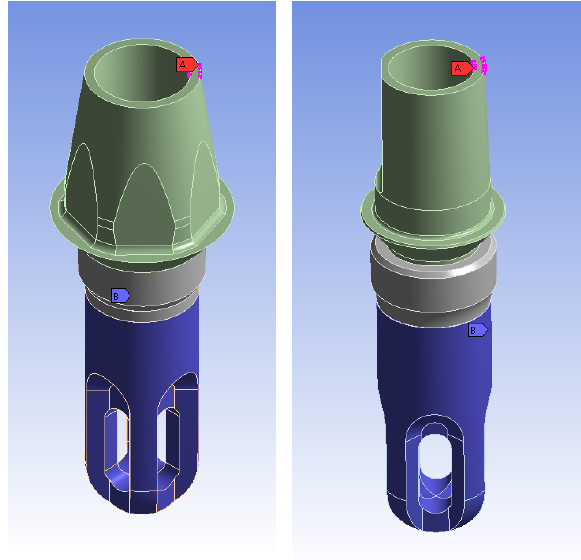
Figure 9. The two geometrical models inside the ANSYS environment. Left– the old EH variant. Right – the new, IH variant. Blue shows the area of fixation (2 mm below the theoretical level of bone), red shows the location of the 30° slanted force. Boundary conditions comply with previous mechani- cal tests and with ISO 14801